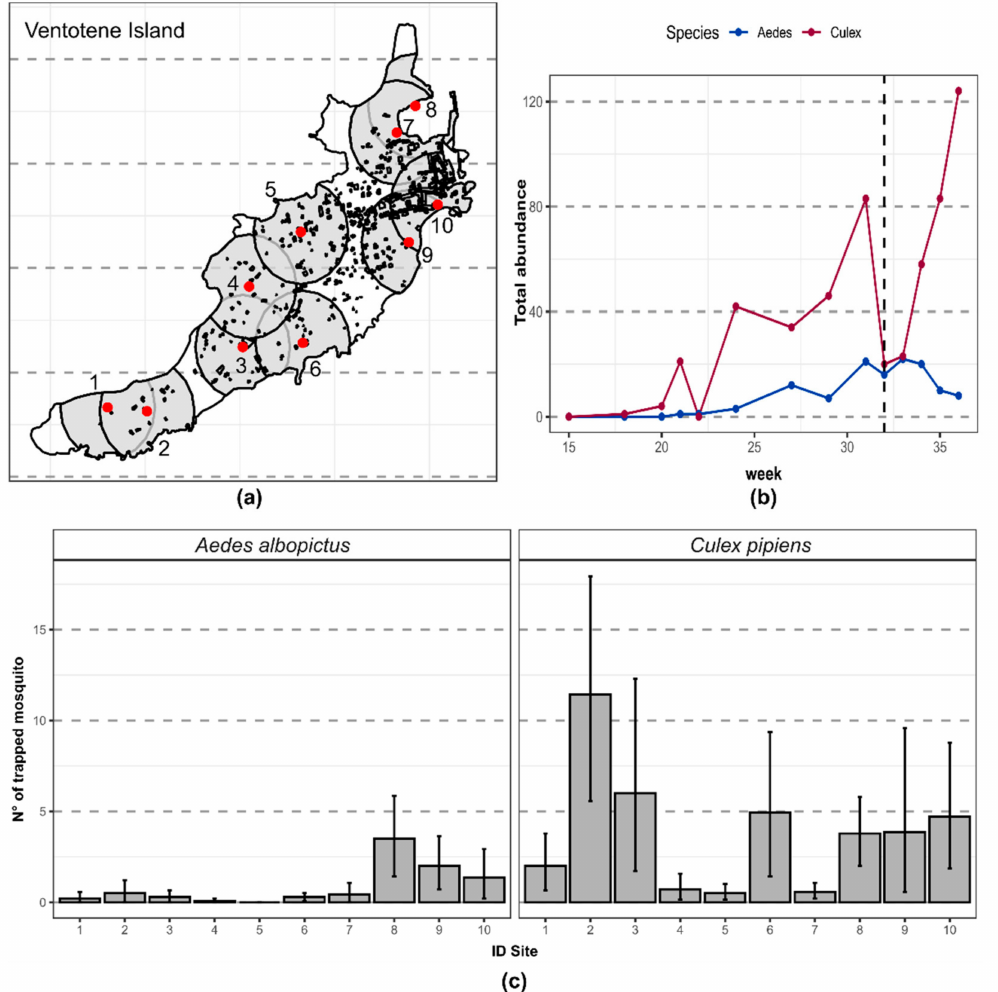
Figure 1. ( a ) Ventotene Island. The red dots are the BG-traps; the number uniquely identifies them along the natural to urban gradient, quantified by the percentage of area covered by buildings (black dots) in a 250 m radius bu ff er around each trap (grey area). ( b ) The total number of mosquitoes collected per species ( Aedes albopictus, Culex pipiens ). On the x-axis, the week of collection is included, while the y-axis presents the total number of mosquitoes captured. The dots represent the week of sampling. The vertical dashed line represents a pest control intervention using insecticide spraying on the island. ( c ) Average number of mosquitoes captured per trap. The x-axis presents the site identification number; see panel ( a ). The y-axis shows the number of mosquitoes captured. Bars represent the average number, and vertical lines represent a 95% confidence interval of the